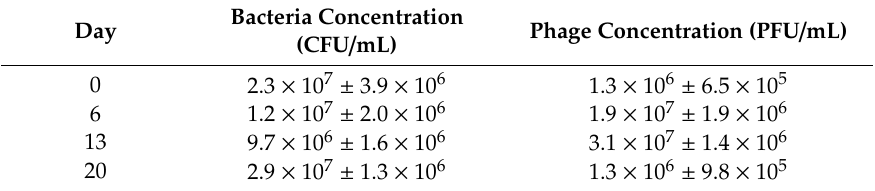
Table 1. Alcaligenaceae H5 and Aquamicrobium phage P14 concentrations during the experiment (phage concentration was determined using Alcaligenaceae H5 for the plaque assay).